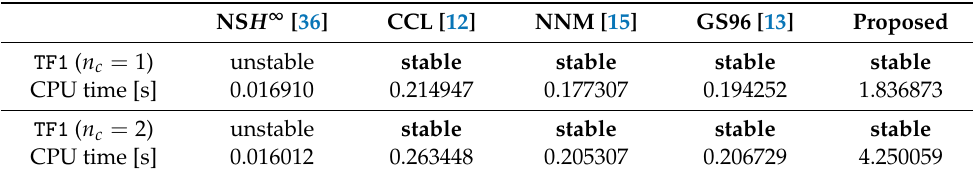
Table 3. Results of stabilizing low-order controllers with n c = 1 and 2 for TF1 .